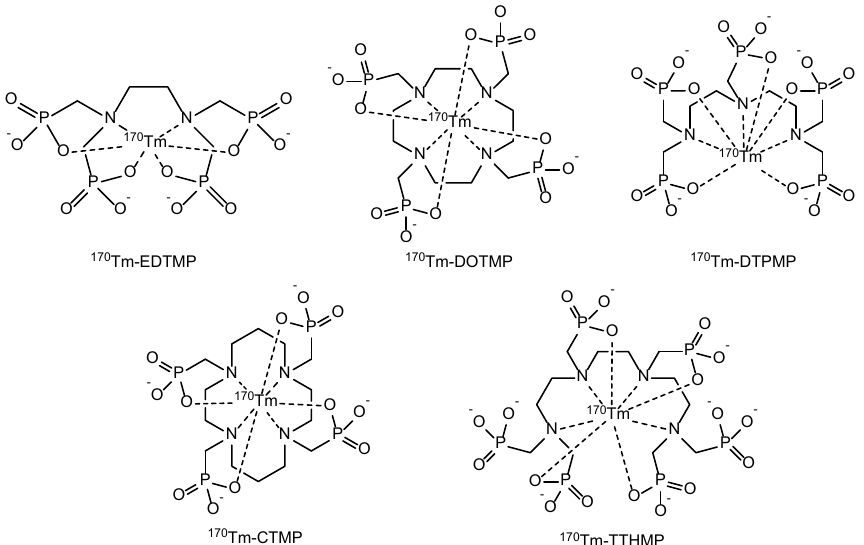
Fig. 12 Structures of 170 Tm-labelled phosphonate